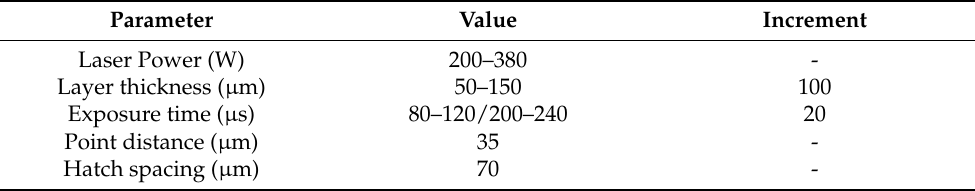
Table 4. The process parameters to improve the forming